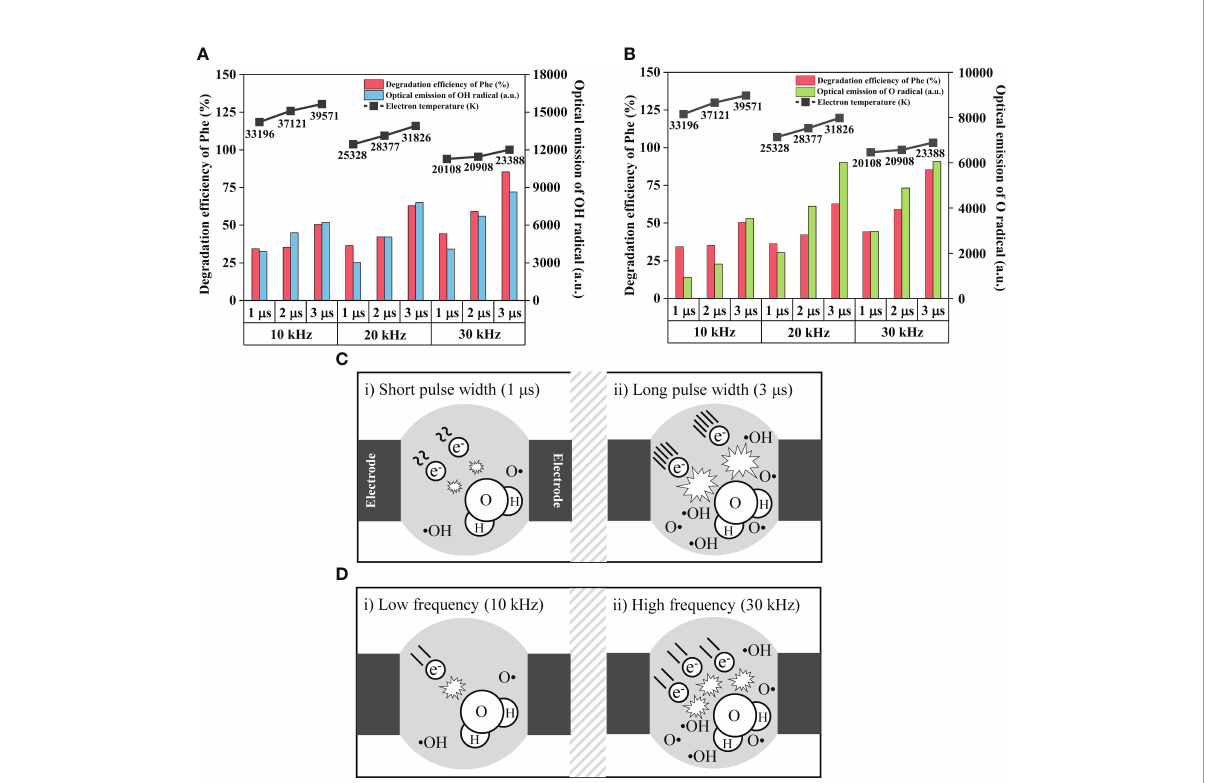
FIGURE 6 Graphical behaviors of electrical discharge conditions, electron temperature, the degradation ef fi ciency of Phe, and the optical emission intensity of (A) hydroxyl radical, and (B) oxygen radical. Mechanism of liquid phase plasma to degrade PAHs with contrasting (C) pulse widths and (D) frequencies. Hydroxyl radical showed the most similar behaviors to the degradation ef fi ciency. Increased pulse widths and frequencies lead to more accelerated electrons and frequent bombardment between electron and surrounding molecule, resulting in increased generation of active species which oxidize PAHs.